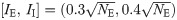
Trained balanced networks.A: Target output Fout (in black) for all the networks in this figure. Red curve is an example readout z(t) from a trained spiking network of N = 200 units. B: Histogram of recurrent weights in three prototypical trained rate networks (N = 300, ϕ = halftanh): i, Zero external current (IE = II = 0) and L2 regularization; ii, [IE,II]=(0.3NE,0.4NE) and L2 regularization; iii, balanced initialization and J0 regularization, external currents as in ii. Regularization parameter α = 1.0 in all three cases. C: Time course of the determinant of the effective matrix Jeff during training of spiking networks of size N = 200 for I of order N (grey dashed lines) and I of order 1 (black line on horizontal axis). Both cases use L2 regularization. D: The full excitatory current and its two defined components (Eqs 4 & 5) as a function of N for a parametrically balanced network performing the task in panel A. E: Time course of the determinant of the effective matrix Jeff during training of spiking networks of size N = 200 for I of order N and J0 regularization. F: The full excitatory current and its two defined components (Eqs 4 & 5) as a function of N for a dynamically balanced network performing the task in panel A. Results in C-F are from ten different initializations of J0 or JT. G: The total average current onto E neurons (hE) and its excitatory (hEE) and inhibitory (hEI) components as a function of network size N for balanced networks (balanced initialization and J0 regularization, full lines) and networks trained with zero external currents (I = 0 and L2 regularization, dashed lines). H: Eigenvalue spectrum of the weight matrices J of two networks trained to perform the task in panel A (N = 200, ϕ = halftanh). Blue: Zero external current (IE = II = 0) and L2 regularization; red: balanced initialization and J0 regularization.